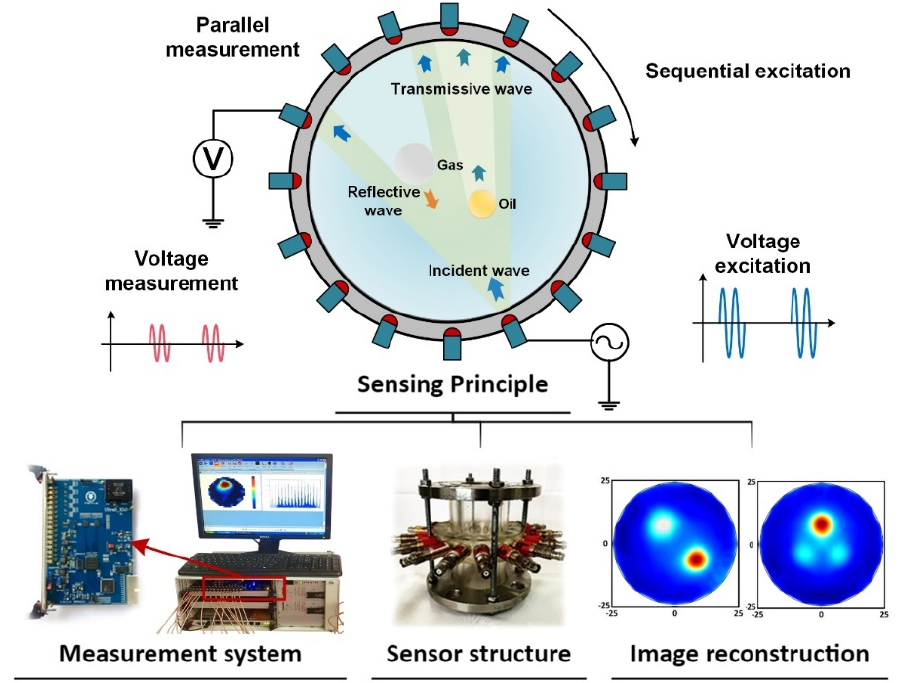
Figure 7. Sensing principle of UPT and image reconstruction of inclusions with different acoustic impedance.